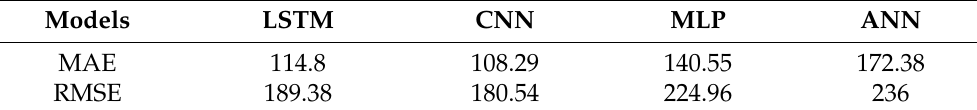
Table 7. Results